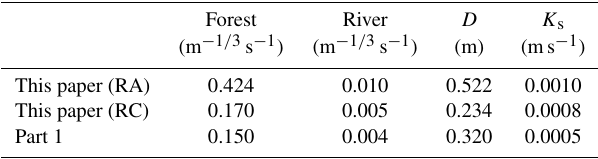
Table 1. The equivalent roughness coefficient of the forest, the Manning coefficient of the river, and identified soil-related parame- ters of Part 2 (this paper) and Part 1 (Kobayashi et al., 2016). Forest